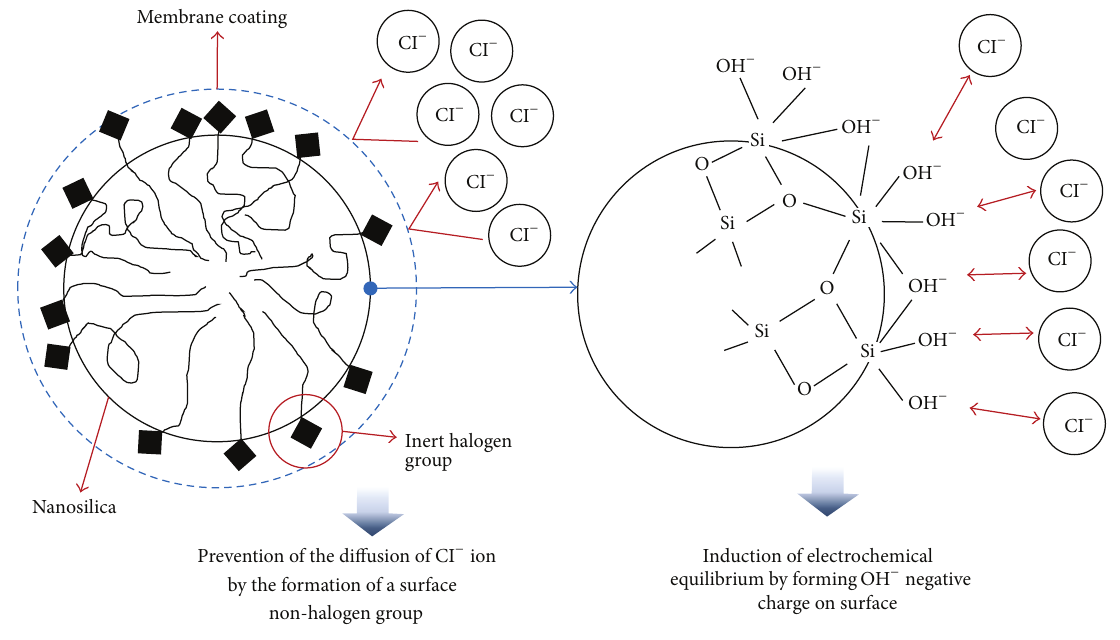
Figure 4: Conceptual diagram for chemical treatment on the surface of SS.